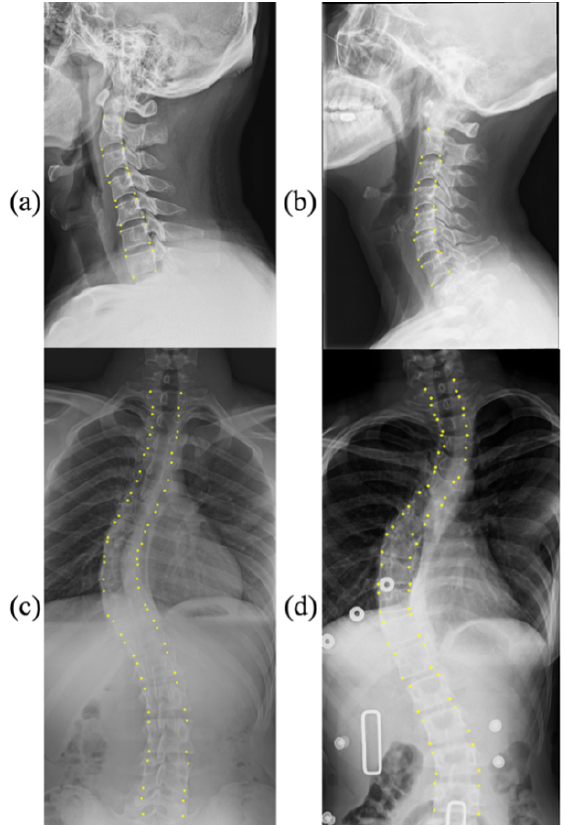
Figure 1. Samples from our dataset CS799 ( a , b ), and the AASCE MICCAI 2019 challenge dataset ( c , d ). The yellow points represent landmarks marked by experts.